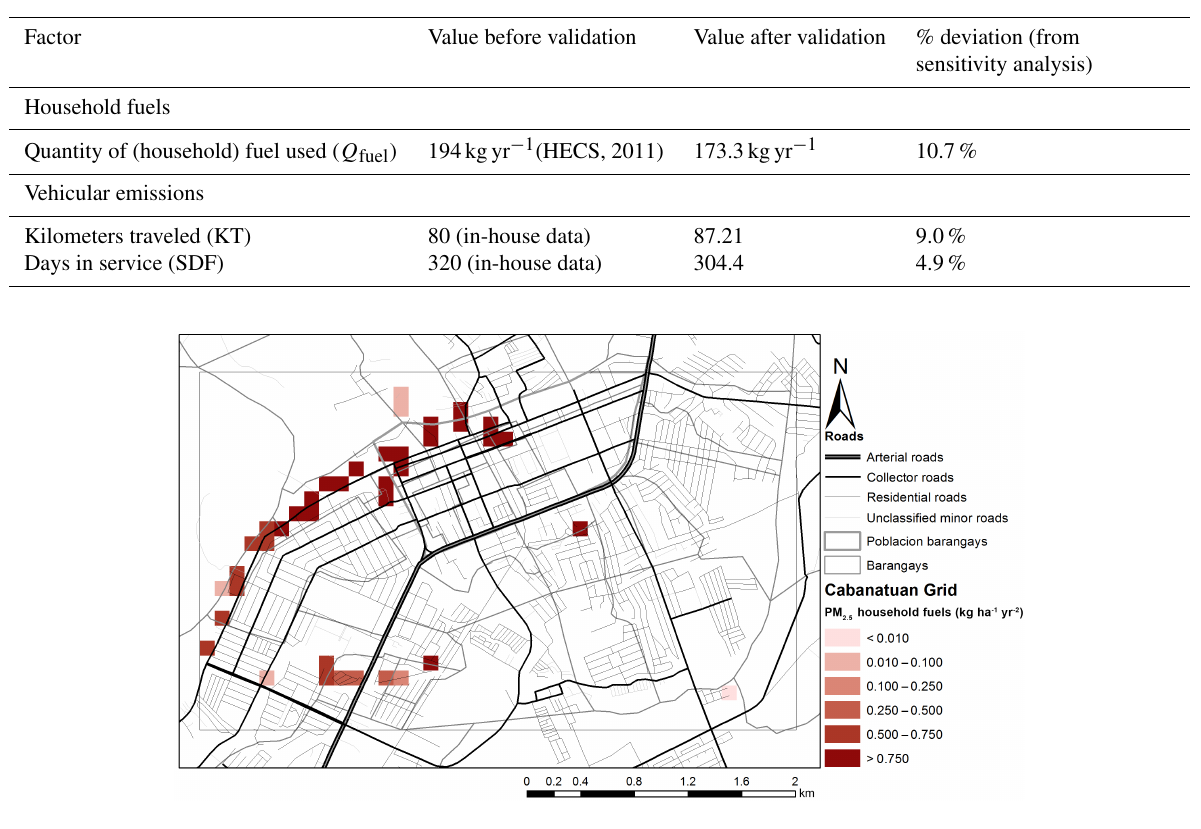
Figure 5. Map of estimated PM 2 . 5 emissions from burning of household fuels. Base map derived from satellite imagery (Google Earth Pro, 2015,